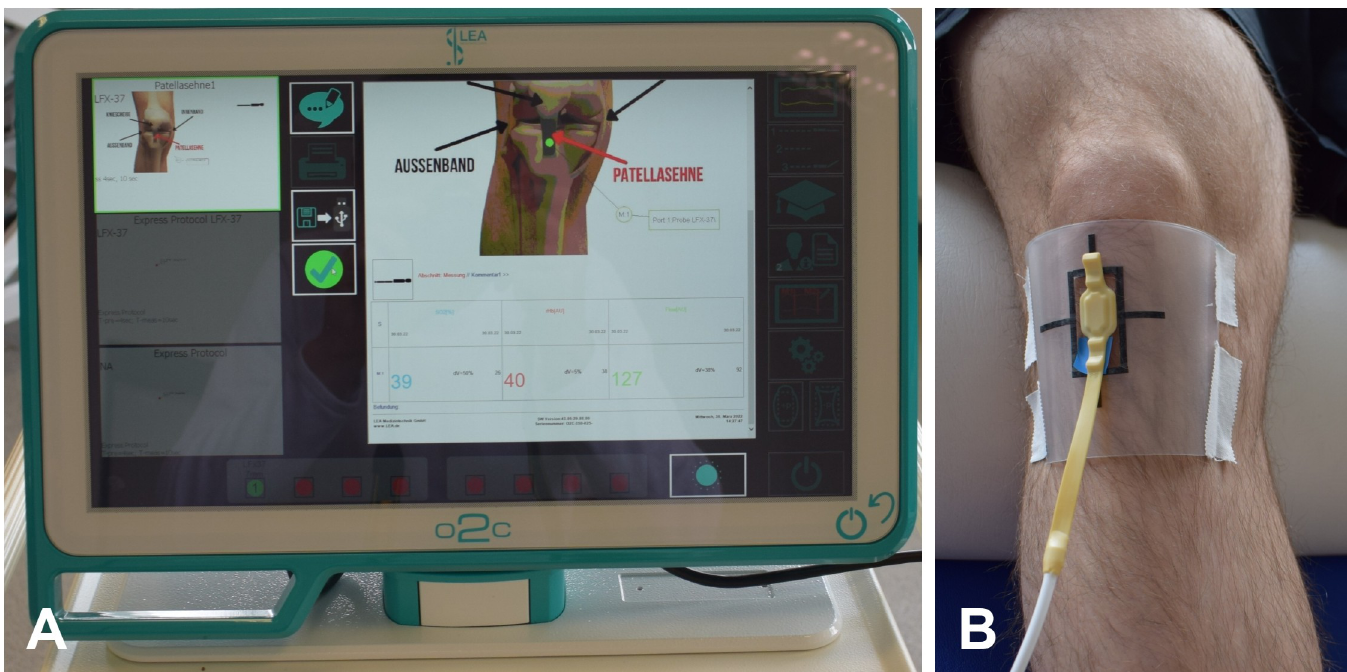
Fig 3. Hardware for microcirculation measurement using a laser Doppler flowmeter and a tissue spectrometer. B: Probe placement. A: